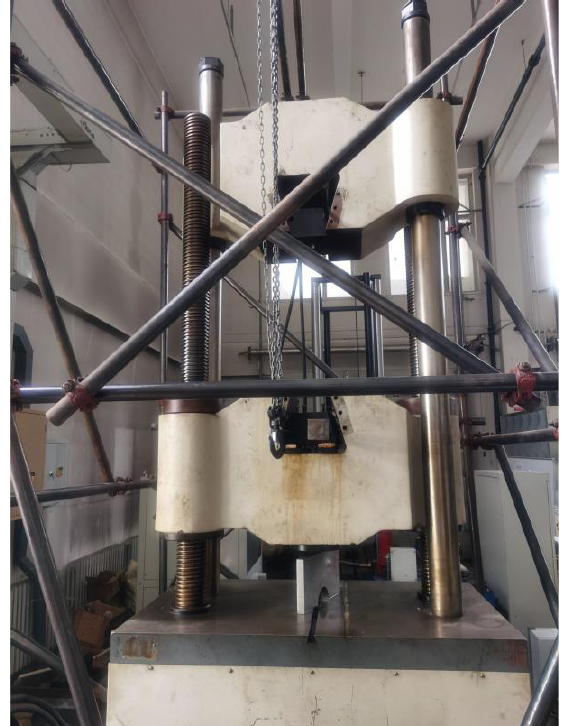
Figure 26. WAW-2000 universal testing machine.